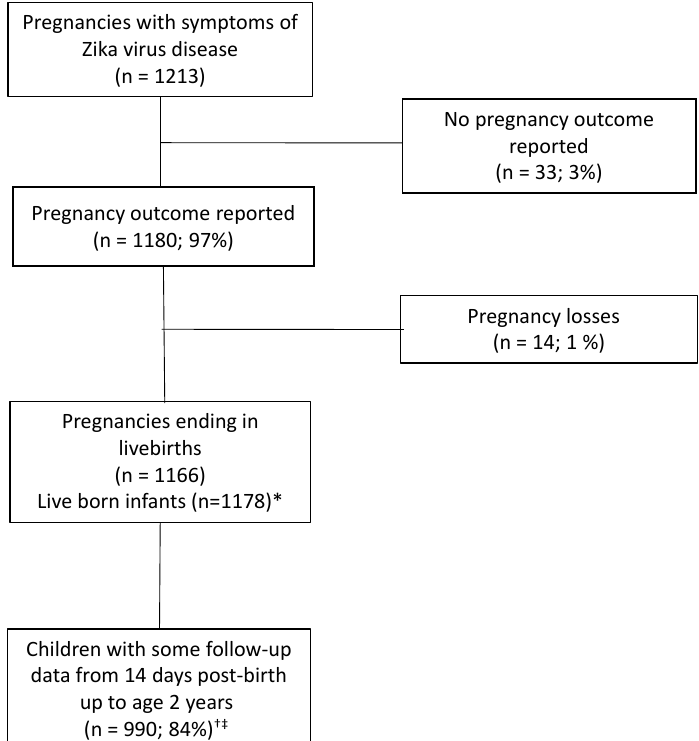
Figure 1. Enrollment of pregnancies and follow-up of children of two years of age, Project Vigilancia de Embarazadas con Zika (VEZ), Colombia, 2016–2018. * Included 12 twin pregnancies † Denominator for percentage is 1178 live born infants ‡ Follow-up data include information for 139 infants who participated in one or more of the Project VEZ brigades. Table 1. Characteristics of pregnant women with symptoms of Zika virus disease and subset with laboratory evidence *